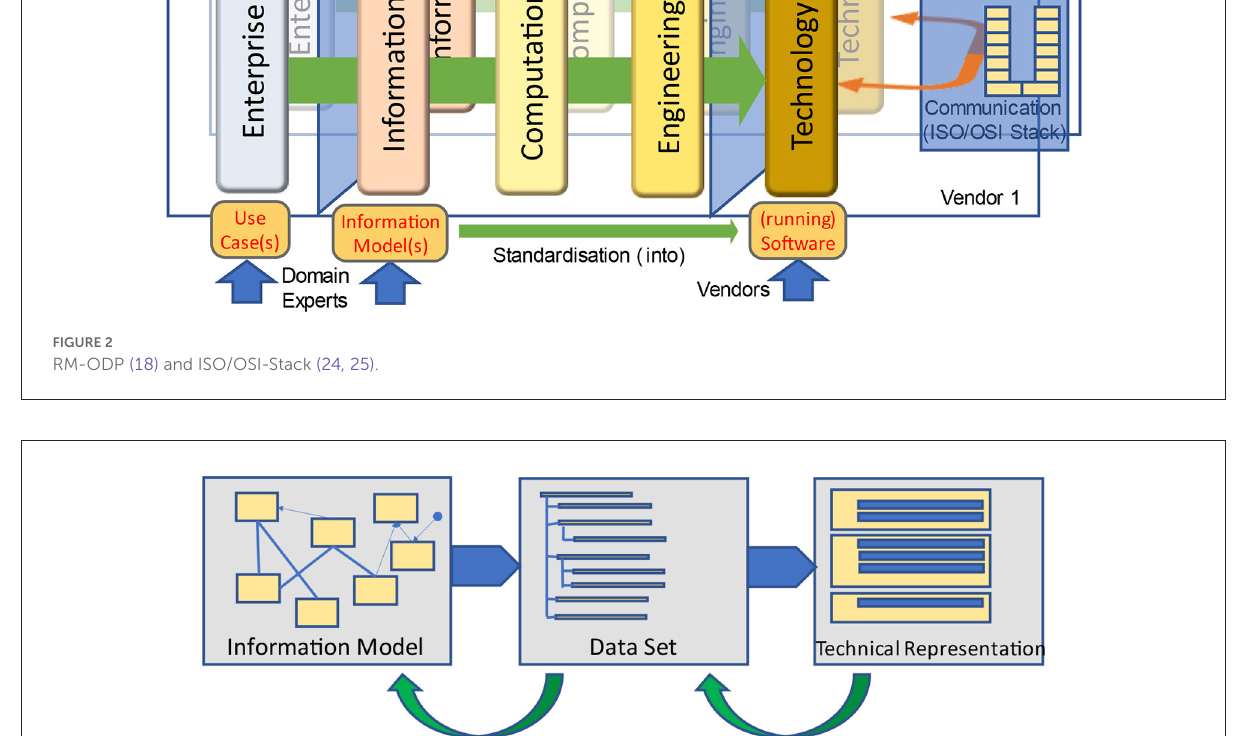
FIGURE3 Derivation